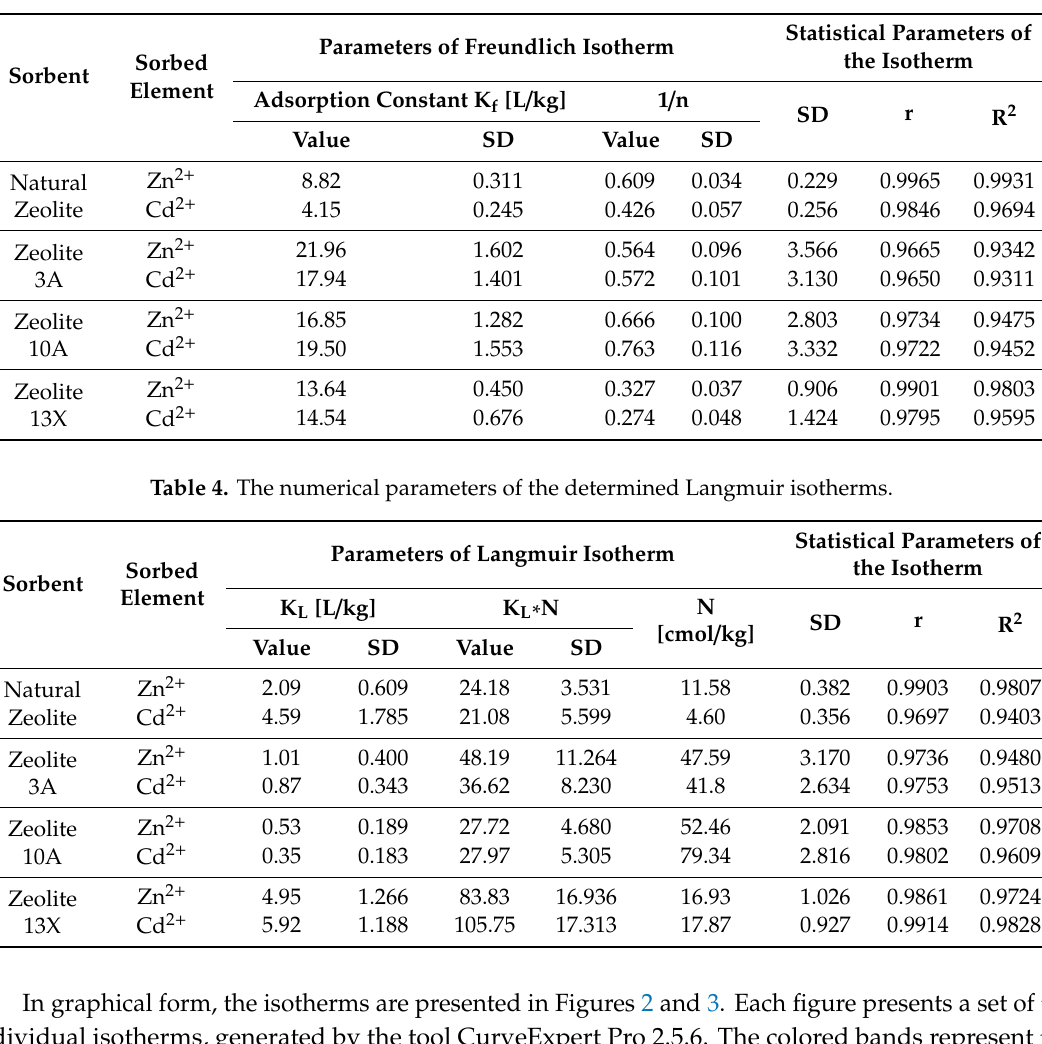
Table 3. The numerical parameters of the determined Freundlich isotherms.